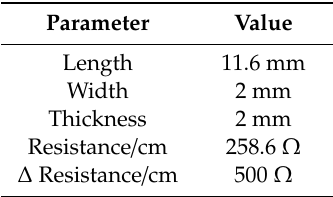
Table 2. Electrical and physical characteristics of a U-shaped rubber